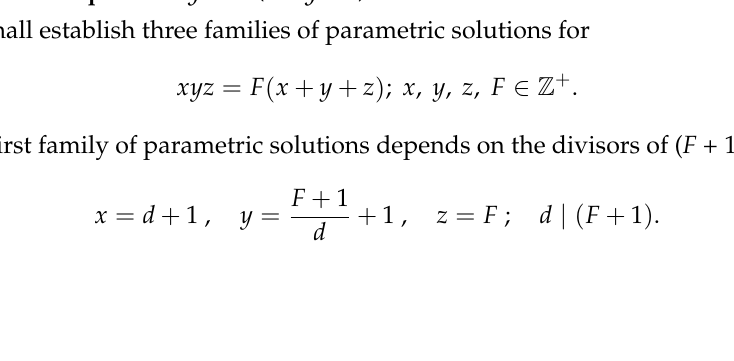
Figure 1. Sum of solution terms of Diophantine equation xy = F ( x + y ). An upper bound and sums of terms for parametric solutions x = F 2 /s 2 + F , y = F + s 2 for s | F are indicated by a red line and open circles, respectively.